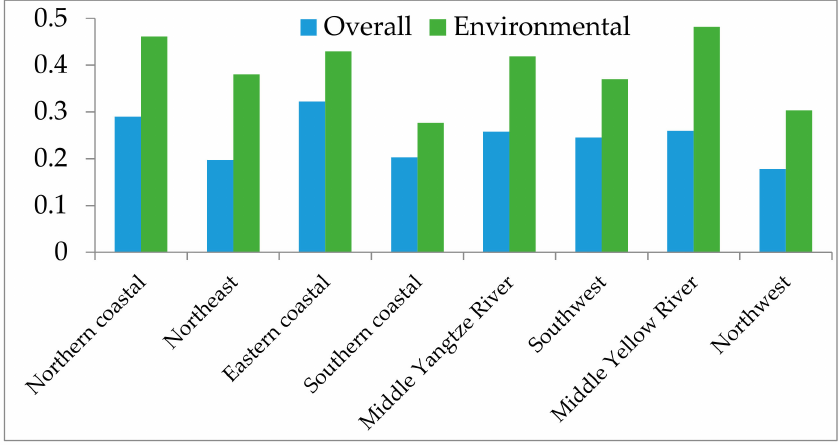
Figure 4. Potential urban public mortality reduction ratio caused by the PM 2.5 concentration for